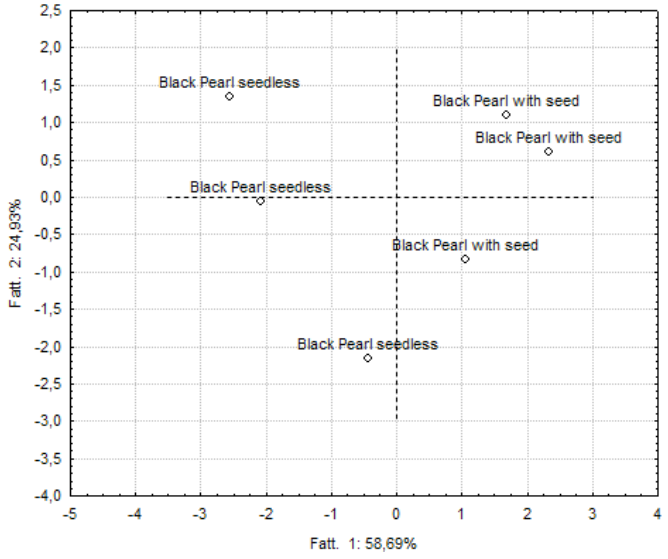
Figure 2. Principal component analysis applied to Black Pearl grape-based smoothies.